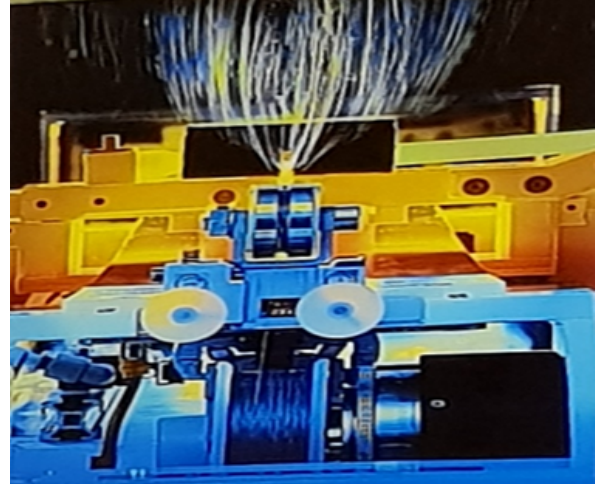
Figure 6: Picture of needleless electro-spinning device at the Textile Research Division, National Research Centre (TRD-NRC) and